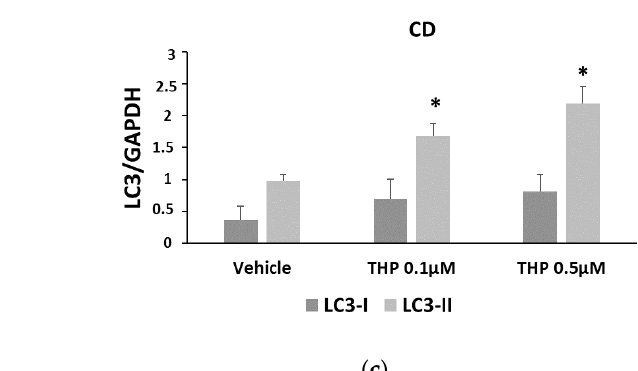
Figure 6. LC3 expression in cells treated with THP ( a ) Representative Western blot anti-LC3 on samples from one control and one celiac culture in the presence of THP for 24 h. ( b , c ) Densitometric analyses relative to Western blot anti-LC3 on samples from three control and three celiac cultures, respectively, in the presence of THP. Protein levels of LC3-I and LC3-II are normalized with respect to GAPDH expression. Data are reported as mean ± SE. * p < 0.05 vs. the respective vehicle.